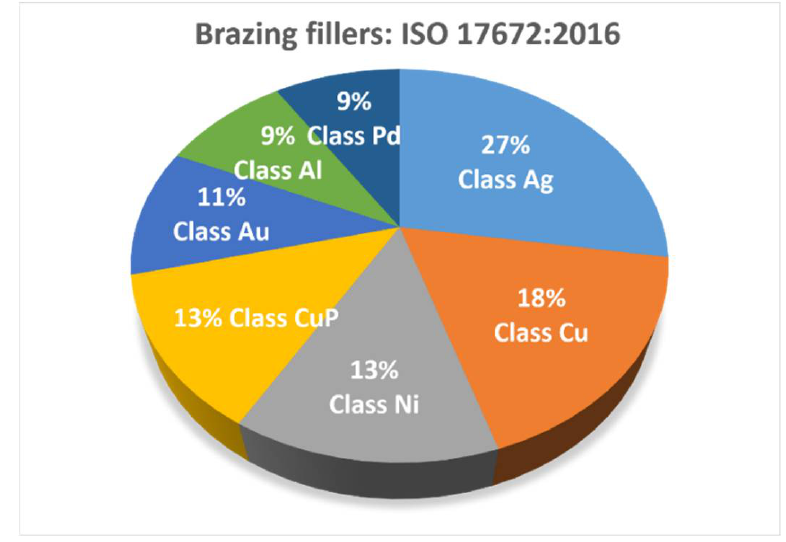
Figure 4. Various classes of brazing fillers according to ISO 17672:2016. The seven subfamilies in each brazing filler class (Al, Ag, CuP, Cu, Ni, Pd, and Au) are summarized in Table 2. The particular applications of these alloys are also indicated. The copper-based fillers used for joining several dissimilar materials are divided into three